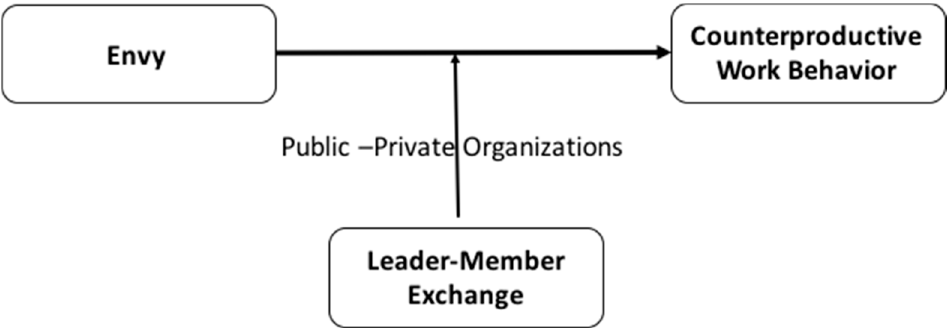
Figure 1. Hypothesized conceptual model.